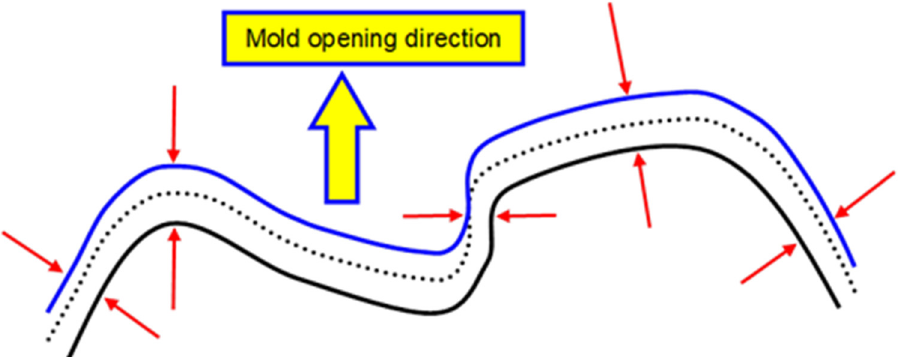
Figure 1. Mold opening in the core-back process causes an increase in the part's local thickness, which locally depends on the mutual orientation between the part and the direction of the mold opening (thin red arrows indicate the local direction of the normal to the surface).